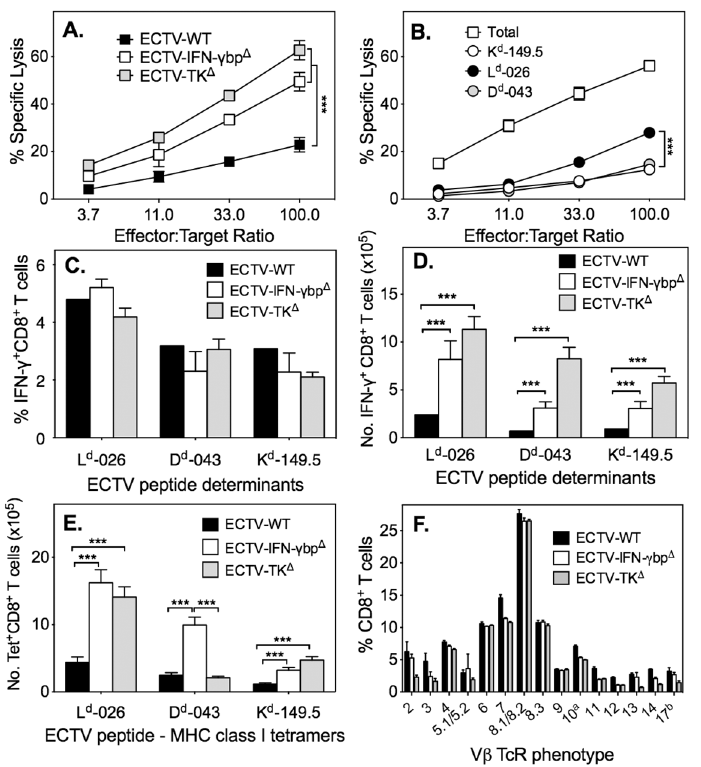
Fig 2. CD8 T cell responses during acute ECTV infection. Groups of female BALB/c mice were infected with 500 PFU ECTV-IFN- γ bp Δ , 500 PFU ECTV-WT or 2 x 10 6 PFU ECTV-TK Δ s.c., sacrificed on day 7 p.i. and splenic antigen-specific CD8 T cell responses were measured. (A) Percent specific lysis of ECTV- infected, 51 Cr-labelled P815 targets by splenocytes from infected mice. *** , P < 0.001 in comparing % specific lysis of virus-infected target cells by splenocytes from ECTV-WT infected mice with splenocytes from ECTV-IFN- γ bp Δ - or ECTV-TK Δ -infected mice at the indicated effector-to-target ratios. (B) Percent specific lysis of virus-infected (Total) or ECTV CD8 T cell determinant-pulsed, 51 Cr-labelled P815 targets by splenocytes from ECTV-IFN- γ bp Δ -infected mice. ** , P < 0.01 and *** , P < 0.001 in comparing % specific lysis of L d -026 peptide-pulsed targets with D d -043 or K d -149.5 peptide-pulsed targets by splenocytes from ECTV-IFN- γ bp Δ -infected mice at the indicated effector-to-target ratios. (C) Percent ECTV peptide determinant-specific IFN- γ + CD8 T cells in spleens of ECTV-IFN- γ bp Δ -infected mice. L d -026-restricted responses were significantly higher ( P < 0.01) compared with D d -043- or K d -149.5-restricted responses. (D) Numbers of ECTV-specific IFN- γ + CD8 T cells in spleens of ECTV-IFN- γ bp Δ -infected mice. *** , P < 0.001 for comparisons between groups shown. (E) Numbers of peptide-MHC class I tetramer + CD8 T cells in spleens of ECTV-IFN- γ bp Δ -infected mice. *** , P < 0.001 for comparisons between groups shown. (F) TCR V β chain expression by splenic CD8 T cells from virus-infected mice. P values for all panels were obtained by Mann- Whitney U